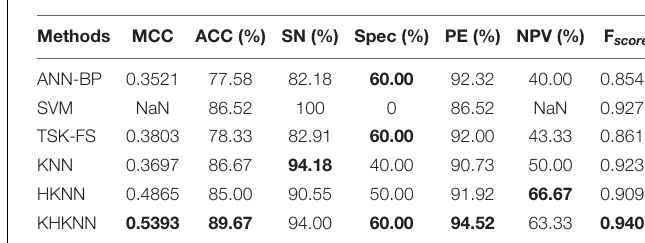
TABLE 2 | Comparison of performance between our method and other existing methods using the PDB1075 data set (Jackknife test